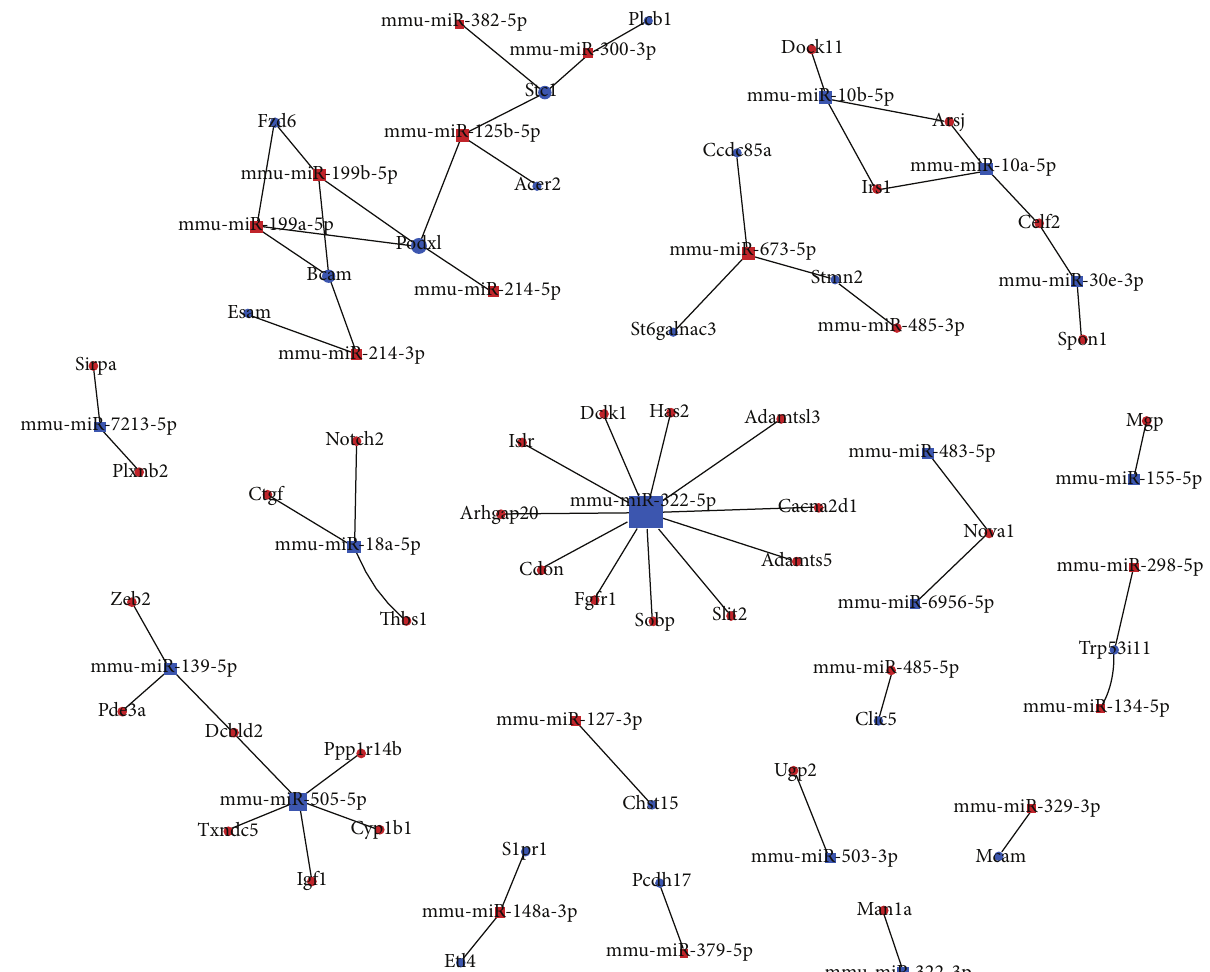
Figure 8: Integrated analysis of the inverse relationship of differentially expressed miRNAs and mRNAs in conjunction with target predictions. Blue box: miRNAs with reduced expression in Sca-1 + CD31 − compared to Sca-1 + CD31 + cells. Blue points: mRNAs with reduced expression in Sca-1 + CD31 − compared to Sca-1 + CD31 + cells. Red box: miRNAs with increased expression in Sca-1 + CD31 − compared to Sca- 1 + CD31 + cells. Red points: mRNAs with increased expression in Sca-1 + CD31 − compared to Sca-1 + CD31 + cells. Block area indicates number of targeted and inversely associated